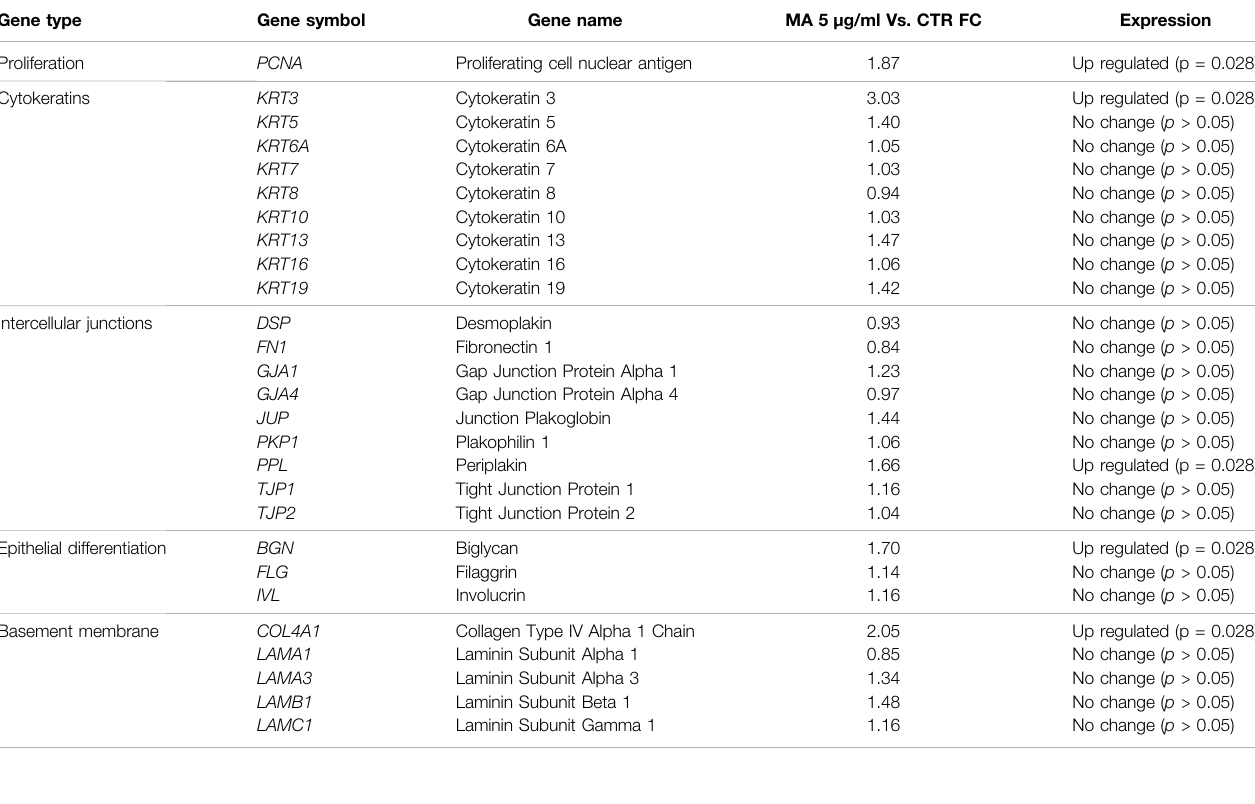
TABLE 1 | Gene expression analysis of immortalized human keratinocytes cultured with maslinic acid. Cells cultures with 5 μ g/mL MA as compared to cells cultured in control medium (CTR). For each gene, the relative fold-change expression of the cells cultured in 5 μ g/ml of MA as compared to controls (CTR) is shown. The column at the right indicates whether the expression of each gene is different in the MA group as compared to CTR (upregulated, downregulated or no change).